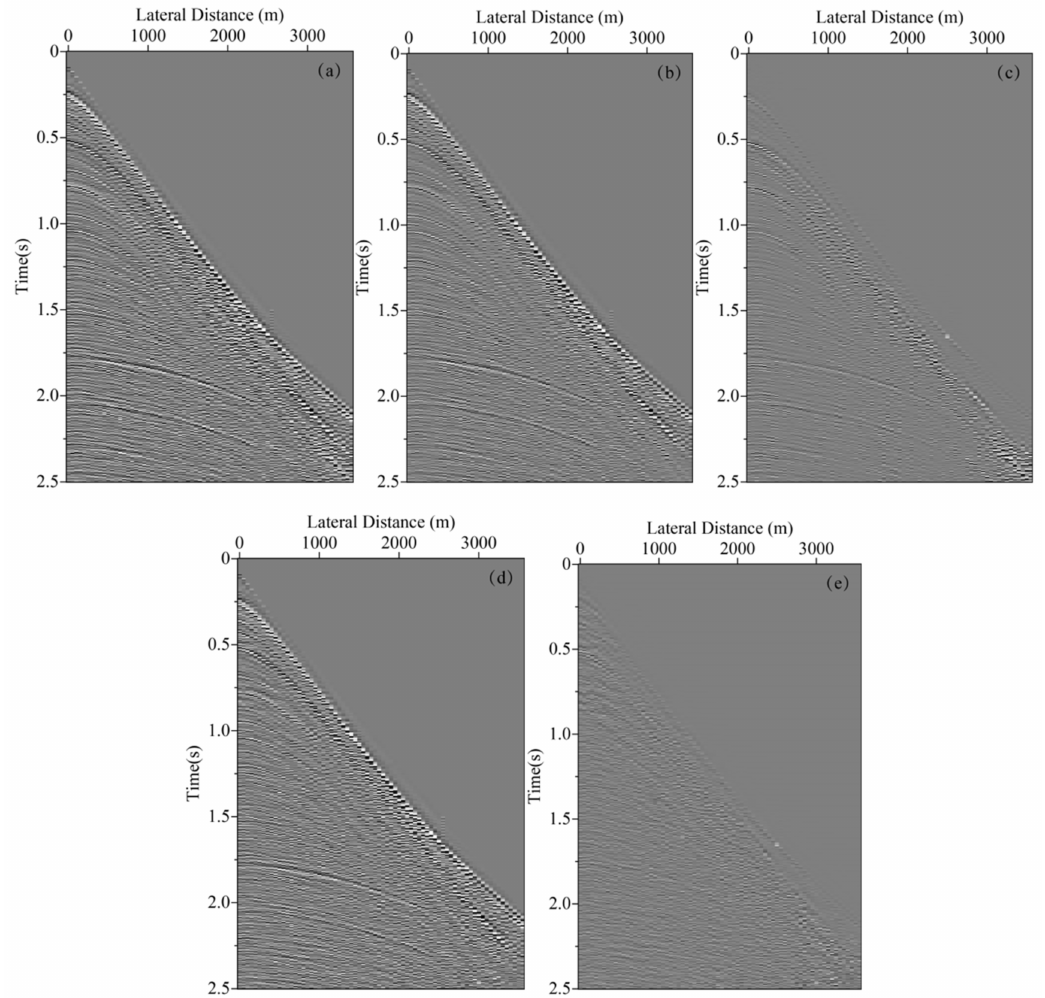
Figure 18. Shot record with multiple elimination using deep learning. ( a ) Shot record with multiples. ( b ) Shot record with multiple elimination using deep learning. ( c ) The predicted multiples (the difference between (( a ) and b )). ( d ) Shot record without multiples. ( e ) The difference between ( b ) and ( d ).